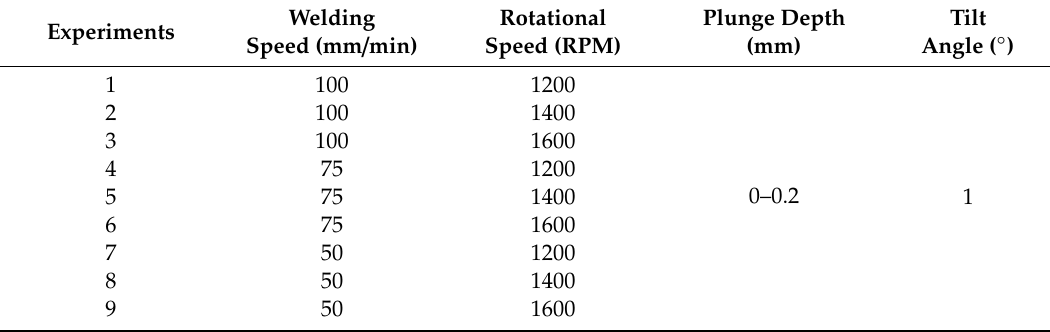
Table 3. Friction stir welding with cover sheet (CFSW) process parameters during experiments. Experiments